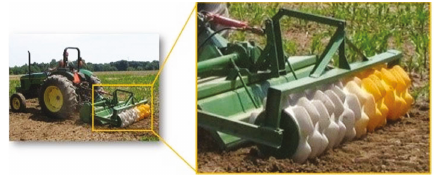
Figure 1: Toothed wheel for soil imprinting on-farm fi